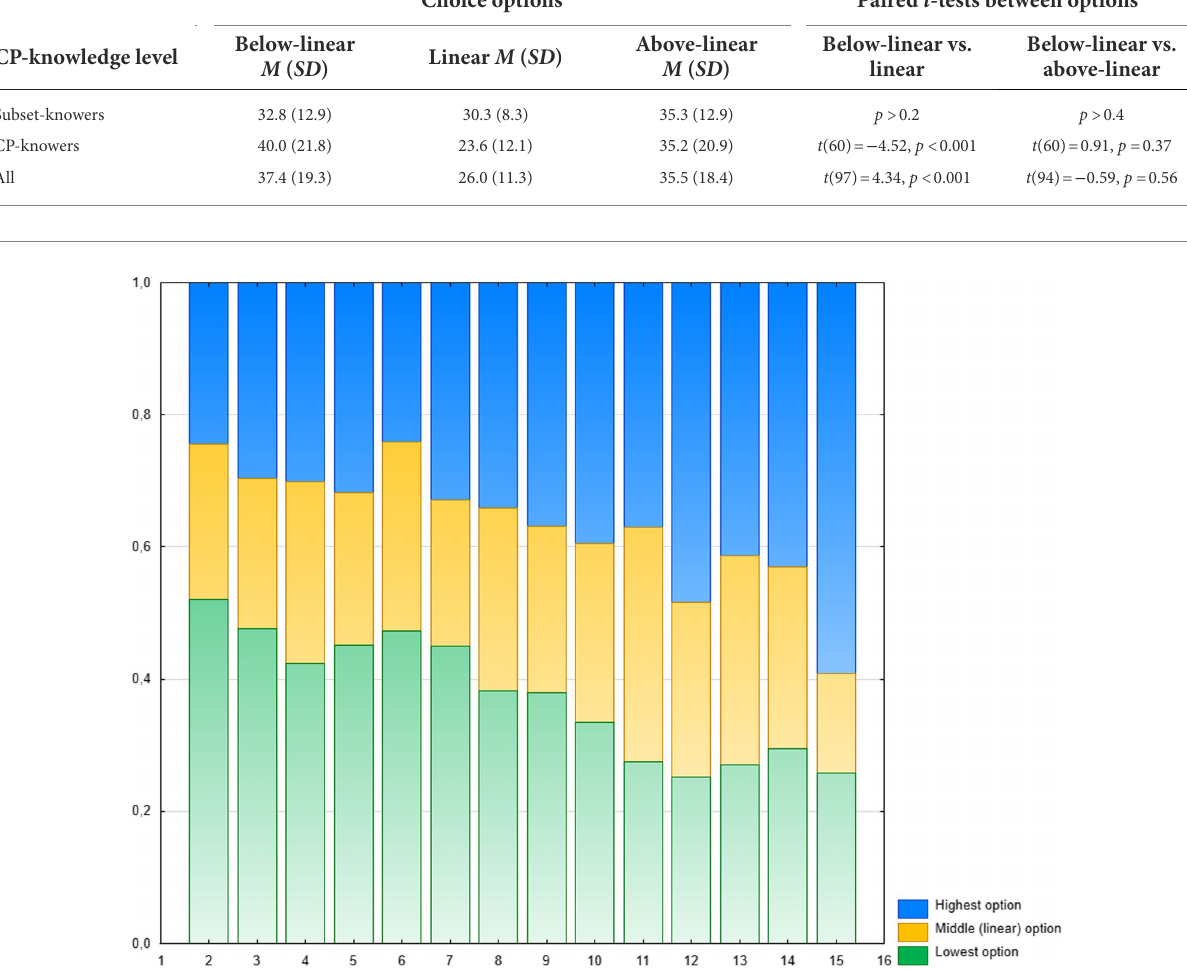
FIGURE 5 Experiment 3: Proportions of the choices of three options: the lowest (green), the middle–linear (yellow) and the highest (blue) for each position on the